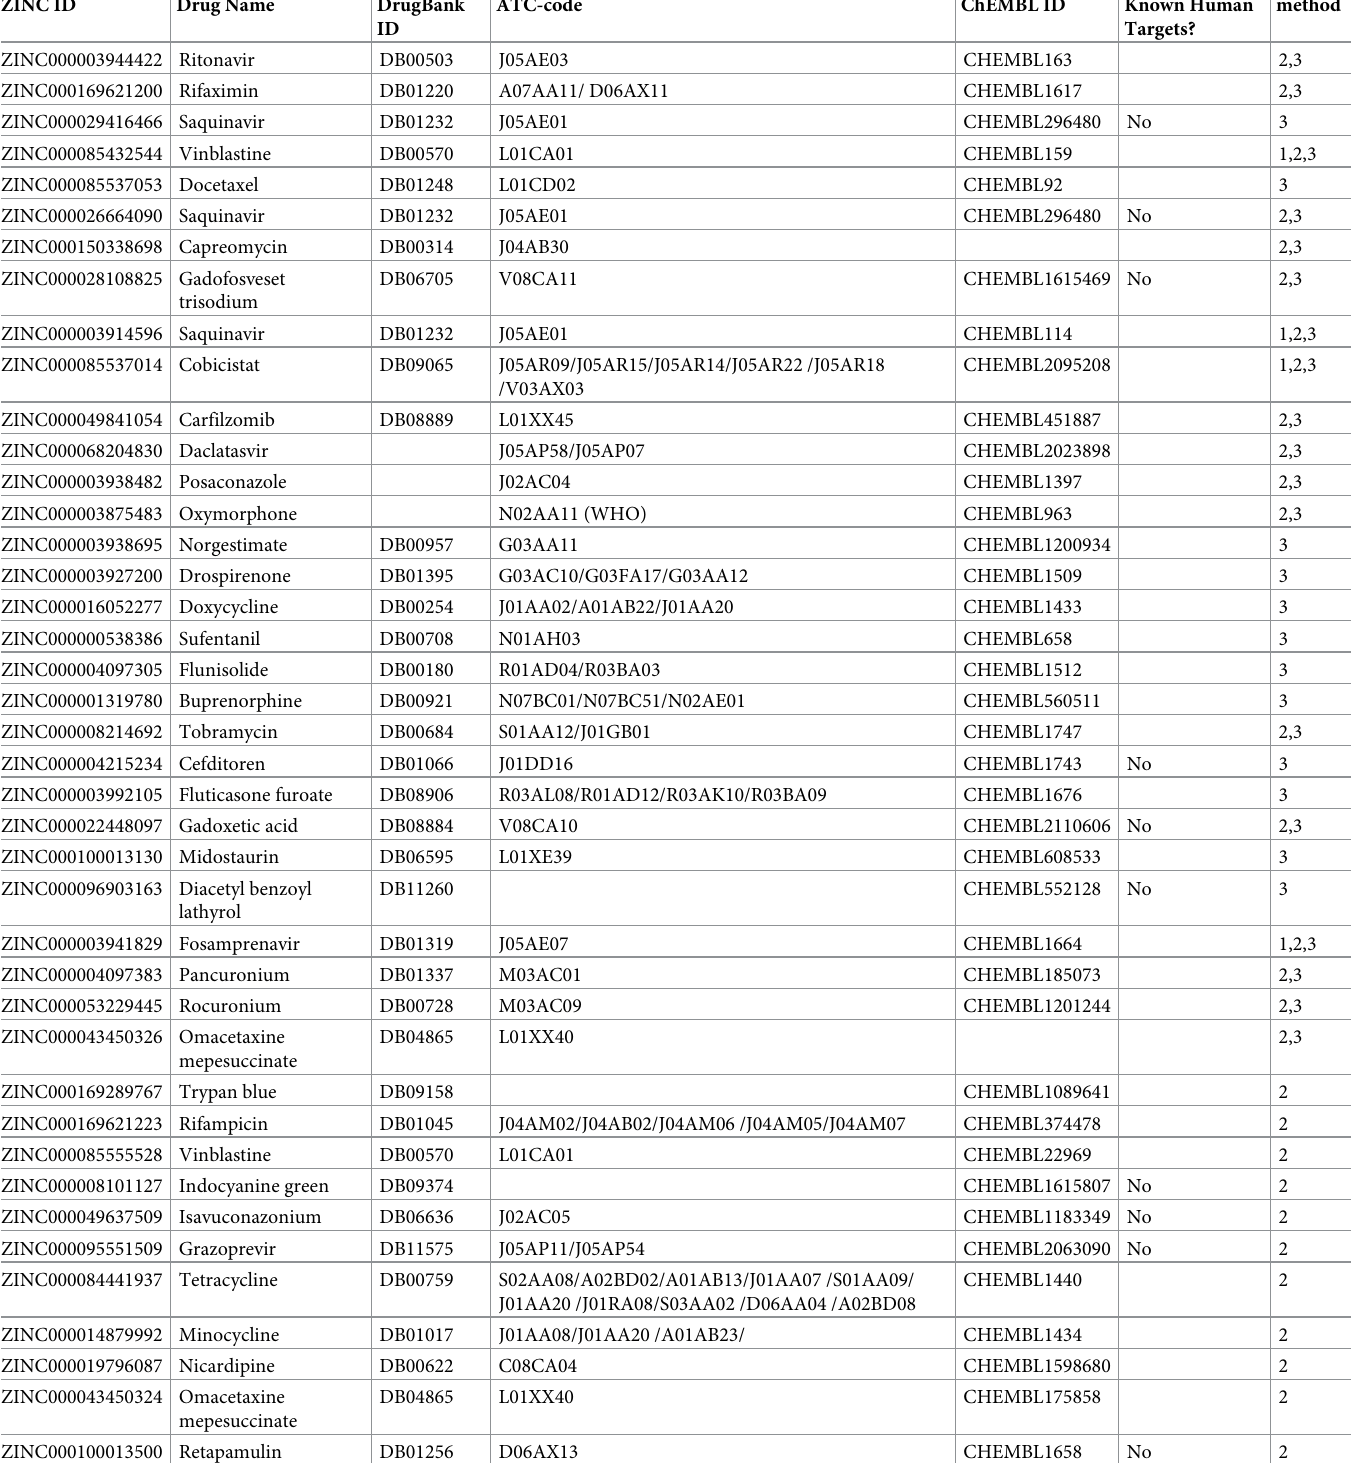
Table 4. IDs and ATC-codes of the selected